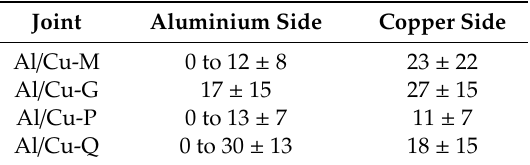
Table 6. The average thickness (in µ m) of intermetallic layers formed at the interface of the joints obtained in this